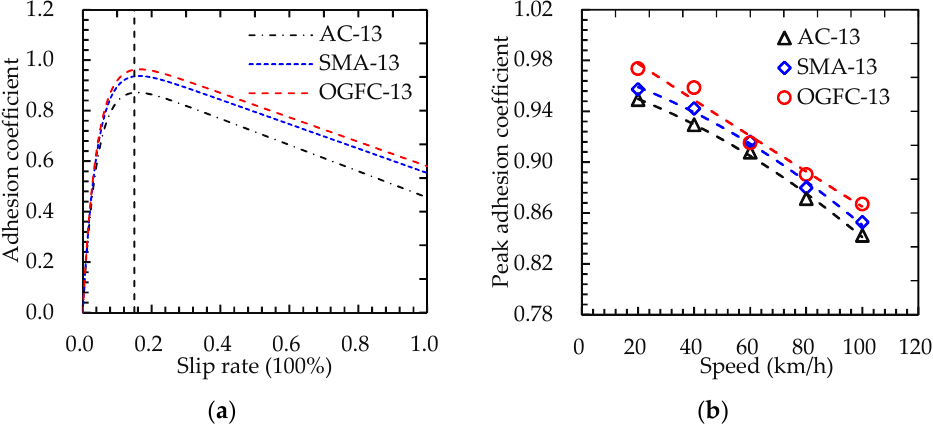
Figure 11. Adhesion characteristics of asphalt pavement in a dry road state: ( a ) variation of adhesion coefficient with slip rate; ( b ) peak adhesion coefficient.